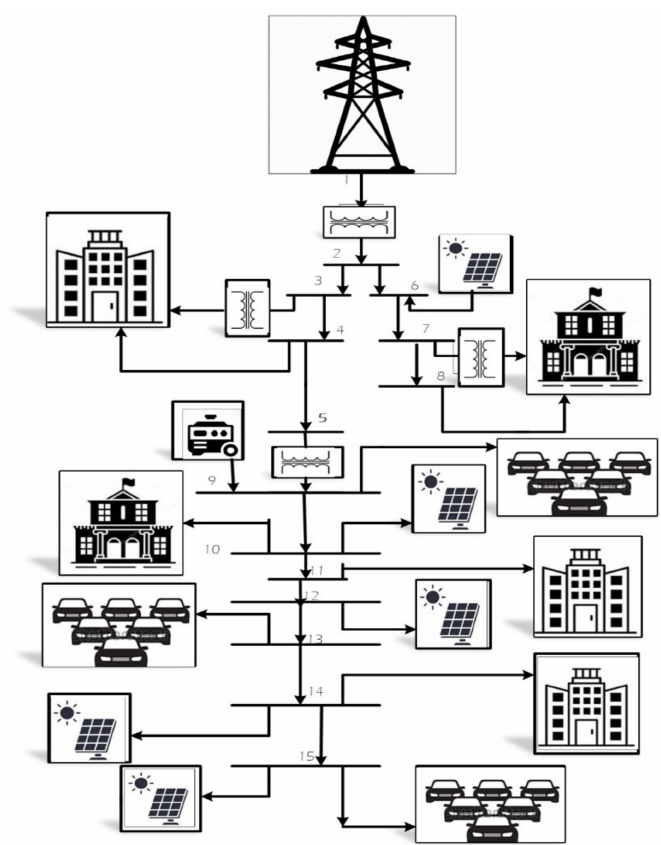
Figure 6. DiSC simulation setup to implement the suggested